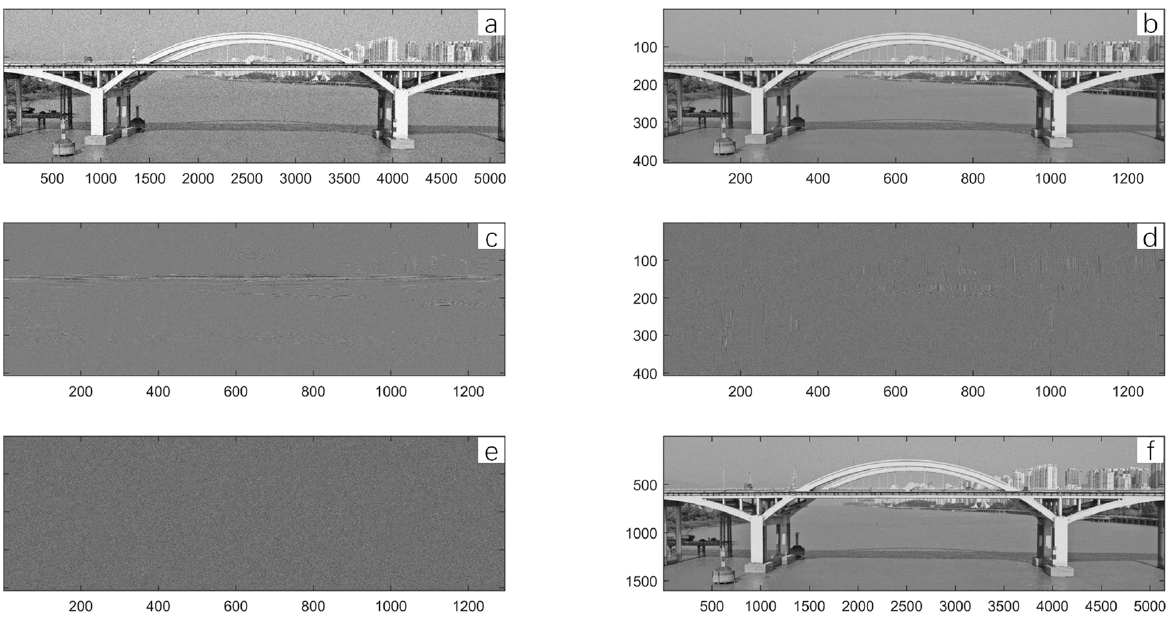
Figure 4. The second level of decomposition ( a ) noisy image; ( b ) approximation coefficient; ( c ) detail coefficient; ( d ) detail coefficient; ( e ) detail coefficient; ( f ) reconstruction result.